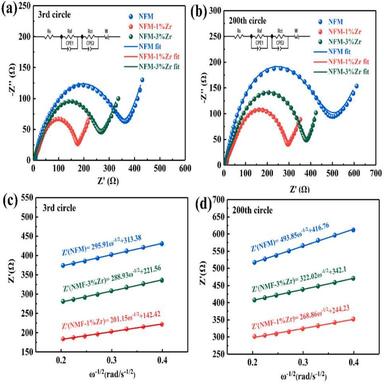
(a, b) Electrochemical Impedance Spectroscopy along with schematic representations of equivalent circuits, (c, d) the correlation between Z ´and ω− 1/2.